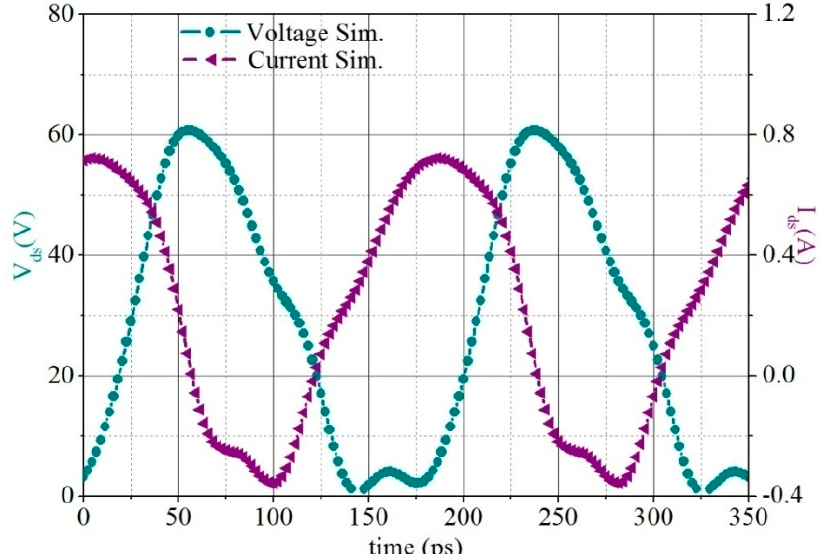
Figure 4. Time domain waveform simulation of the output stage GaN HEMT’s drain voltage and current.